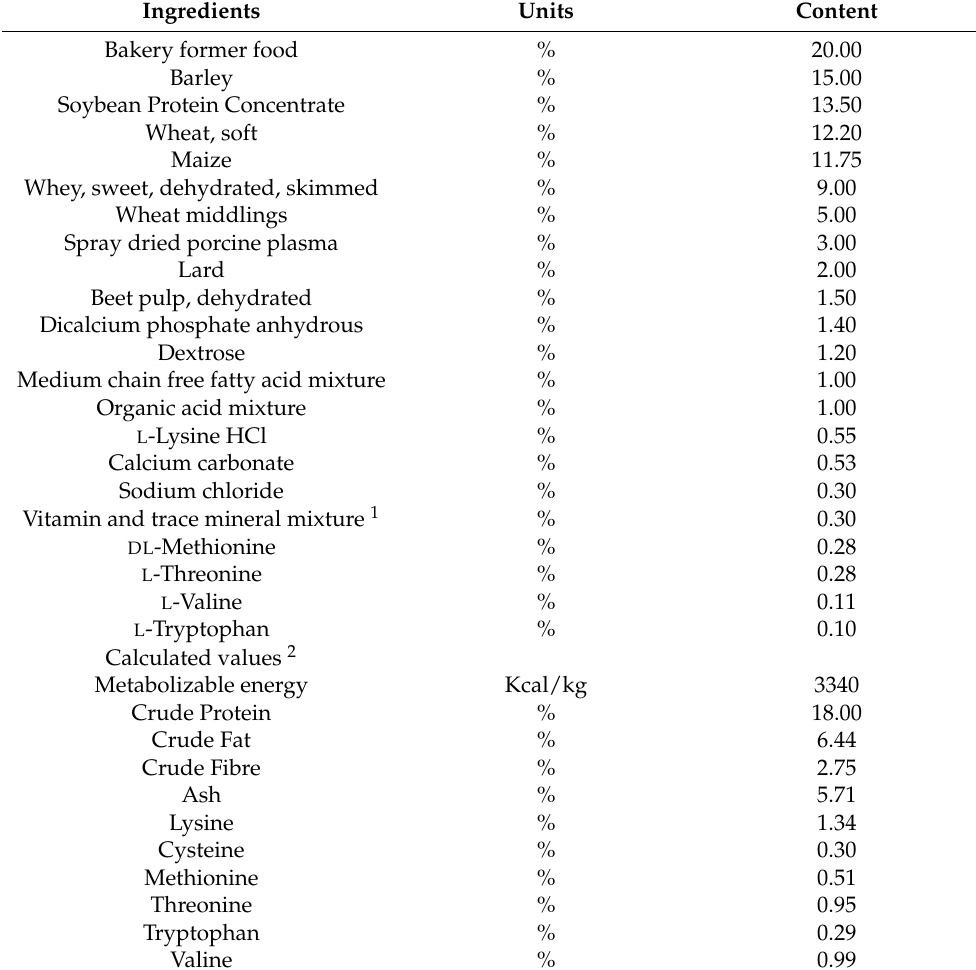
Table 1. Ingredients and calculated composition of the feed expressed on as